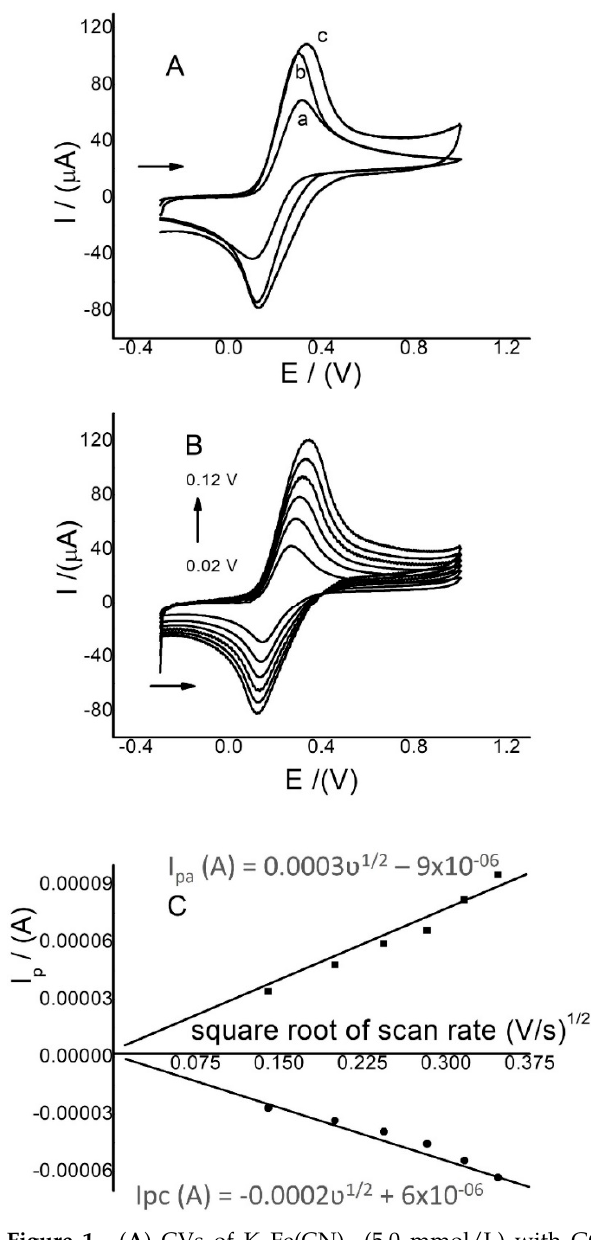
Figure 1. ( A ) CVs of K 4 Fe(CN) 6 (5.0 mmol/L) with GCE (curve a), Ch/GCE (curve b), and Ch-G/GCE (curve c) at 0.10 V/s; ( B ) CVs of K 4 Fe(CN) 6 (5.0 mmol/L) at scan rates between 0.02–0.12 V/s with Ch-G/GCE; and ( C ) plot of I p ( A ) versus ʋ 1/2 (V/s).